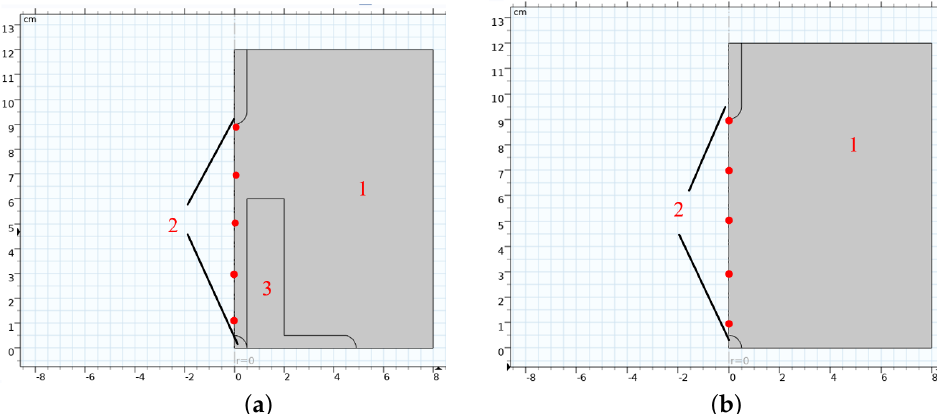
Figure 4. Geometric modeling of SMTS and the original multi-compression structure: ( a ) Model diagram of SMTS. ( b ) Model diagram of the original multi-compression